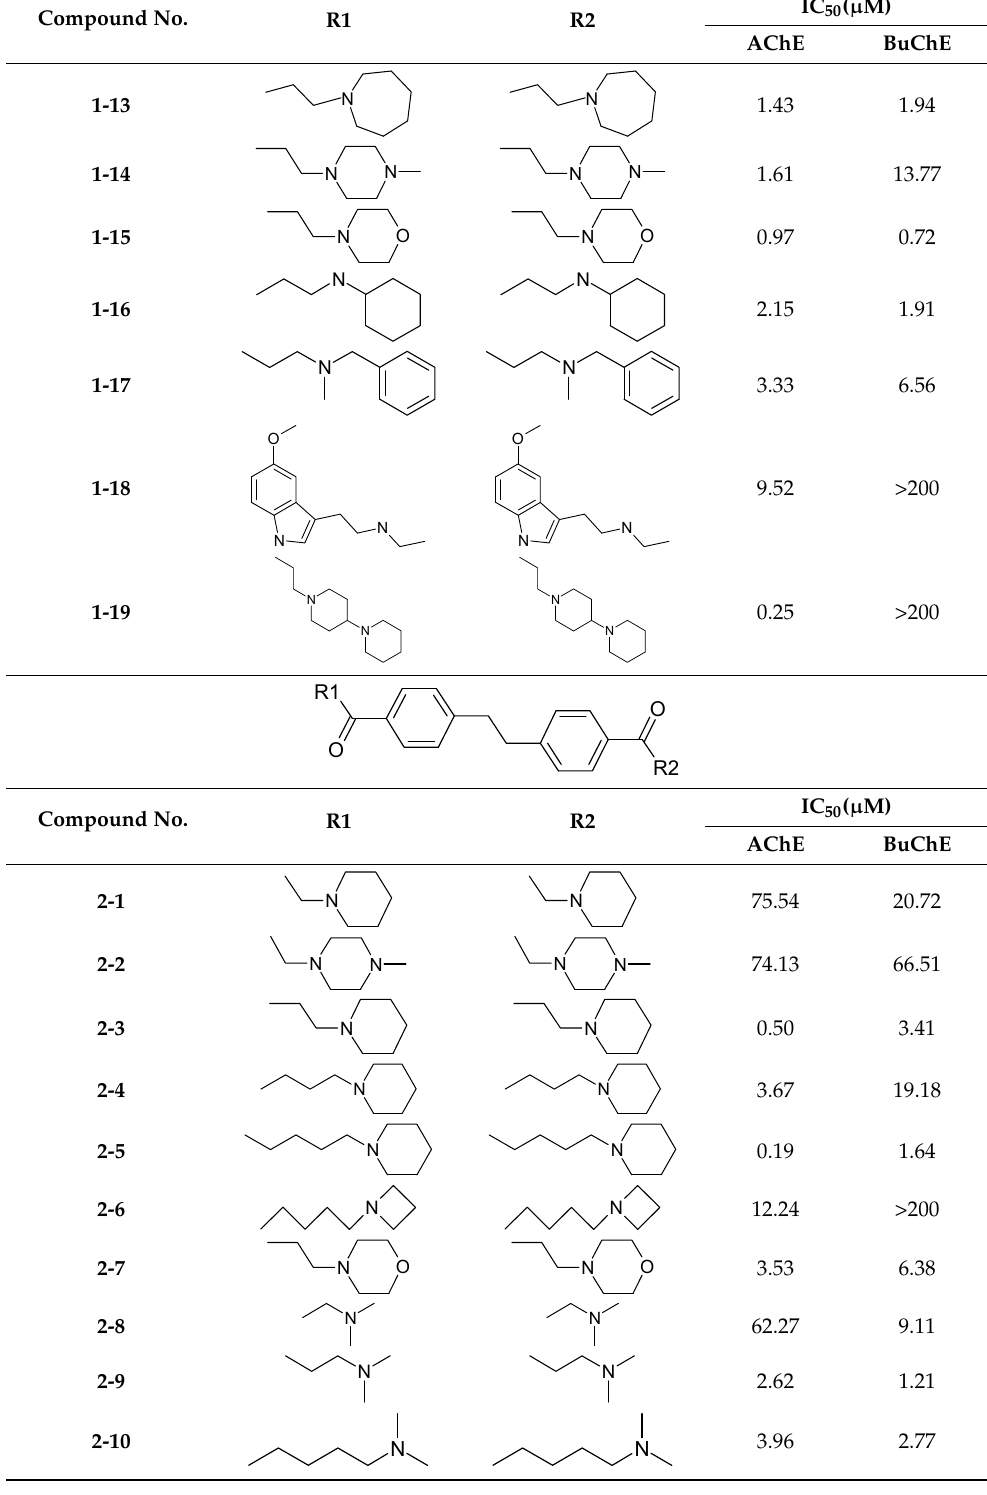
Table 1. The chemical structures and biological activities of DL0410 and its 50 derivatives as AChE and BuChE inhibitors.